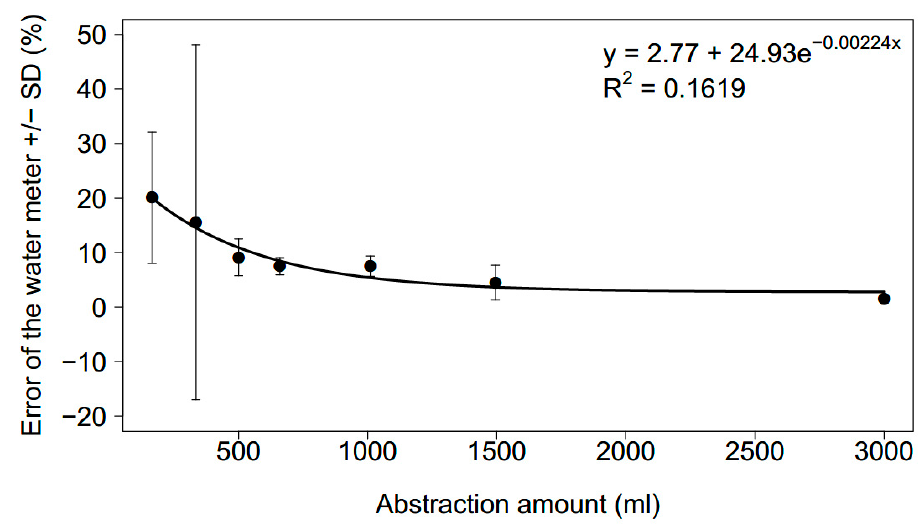
Figure 5. Relationship between the mean error of the water meter per refill event (with standard deviation) and the abstracted volume from the water supply device. N = 40 for each abstraction volume.